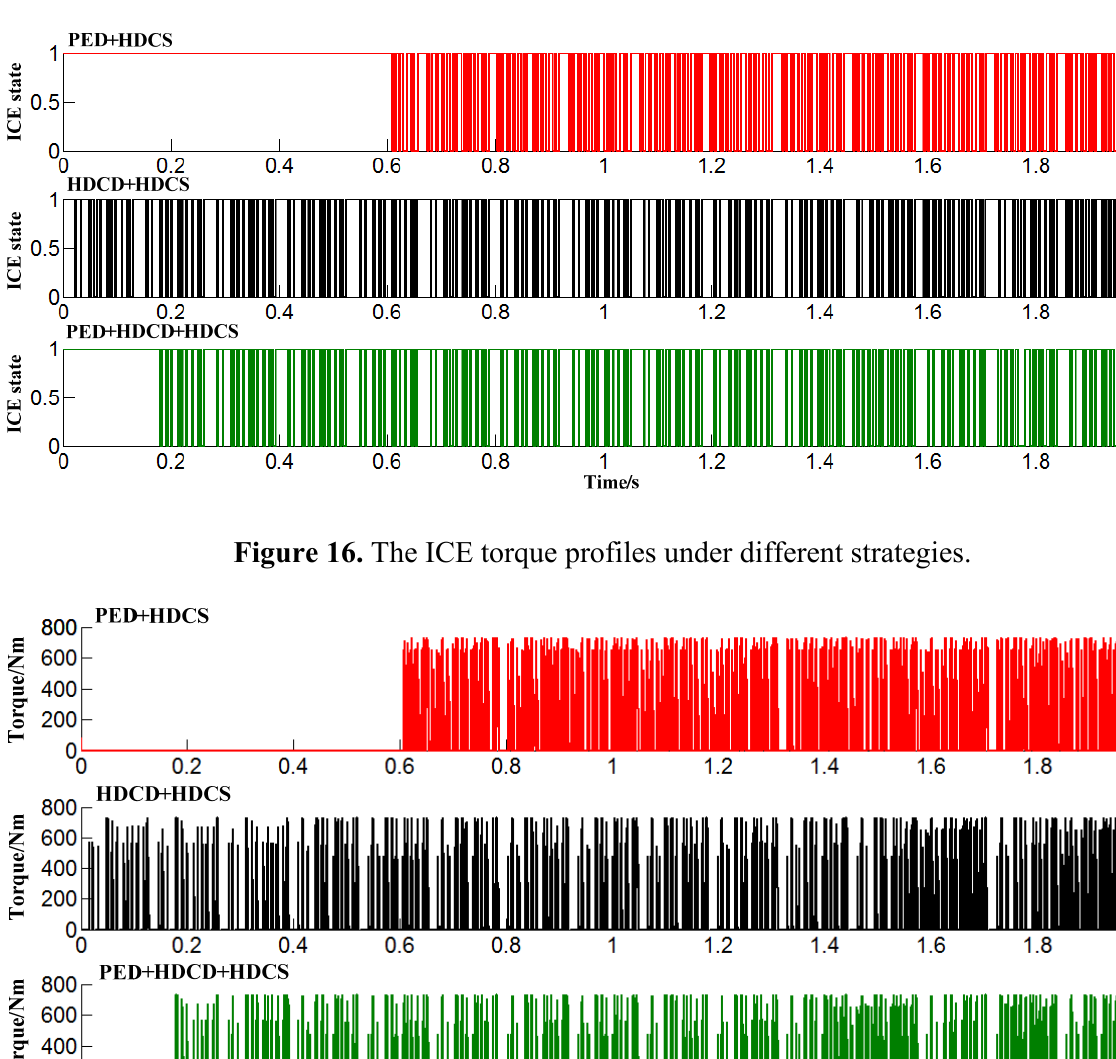
Figure 15. The ICE working state profiles under different strategies.